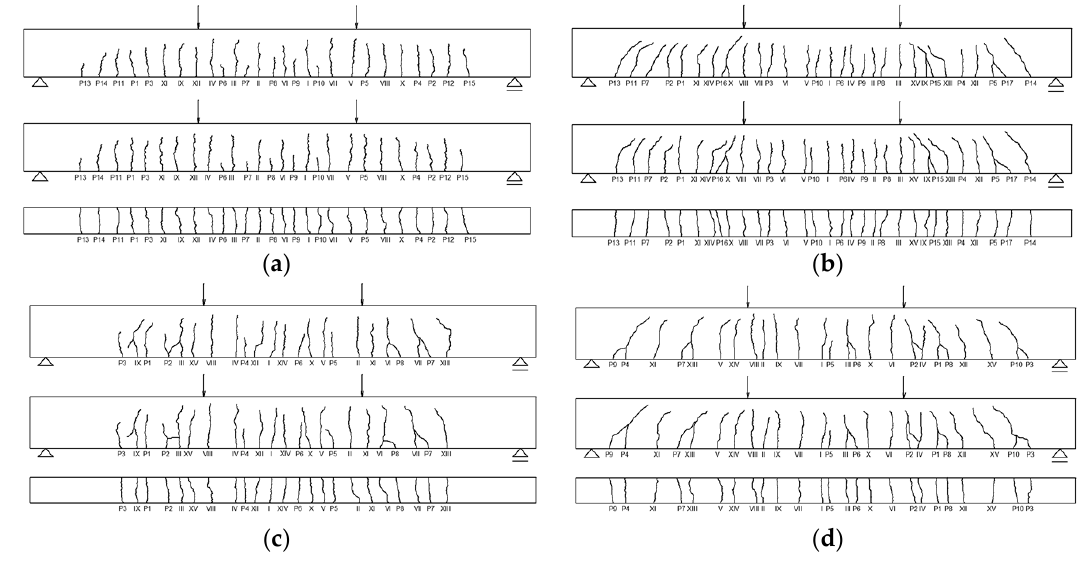
Figure 2. Typical crack patterns on both sides and bottom surfaces for the Specimens - ( a ) type A, ( b ) type B, ( c ) type C, ( d ) type